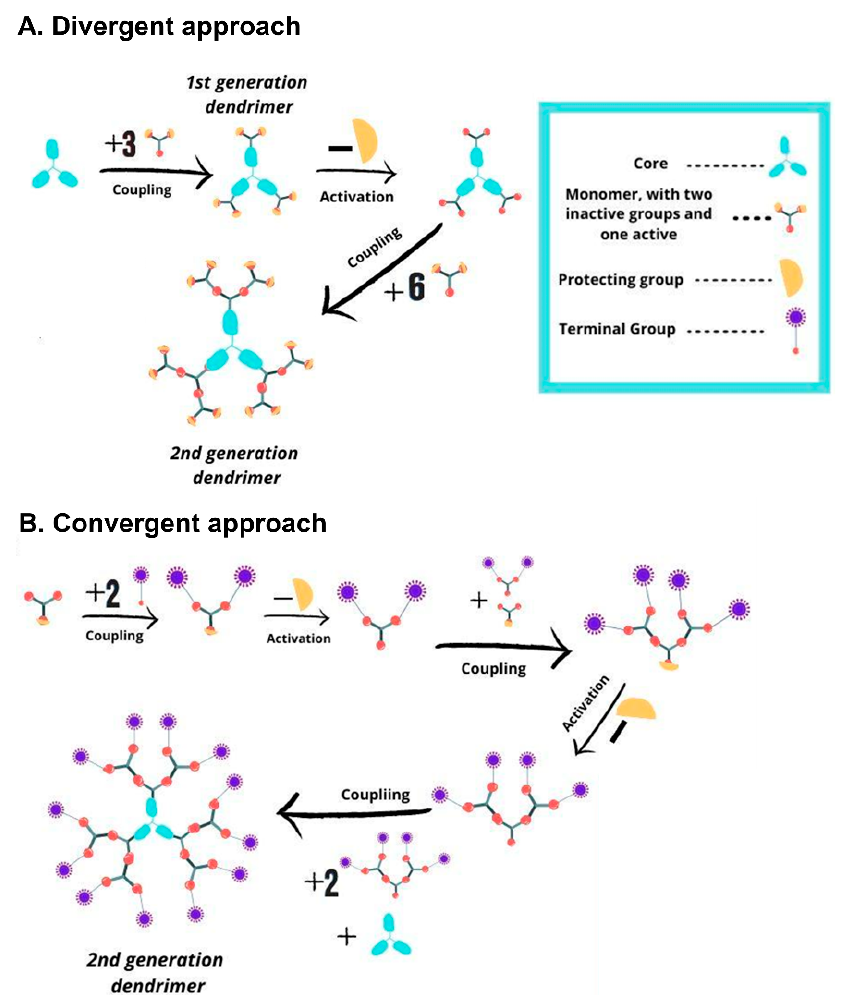
Figure 1. Scheme depicting the traditional synthetic approaches to dendrimers. ( A ) Divergent growth approach, inside-out strategy from the core. ( B ) Convergent growth approach, outside-in strategy from the terminal groups.